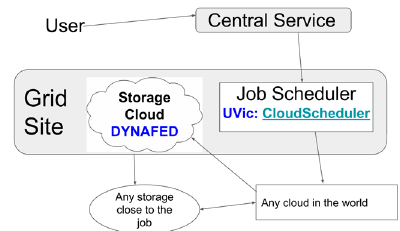
Figure 2: Grid site with distributed compute and storage endpoints located